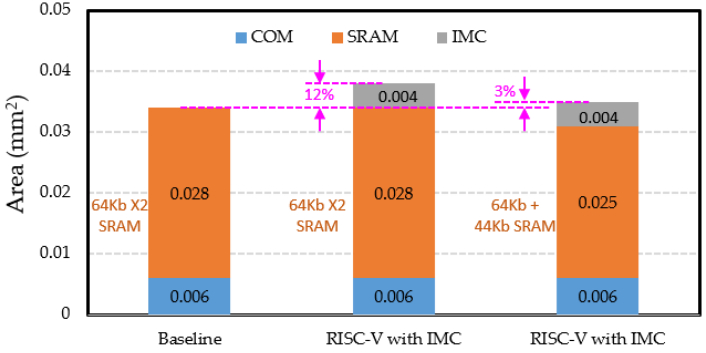
Figure 7. Area comparison between the baseline and the proposed RISC-V with IMC.